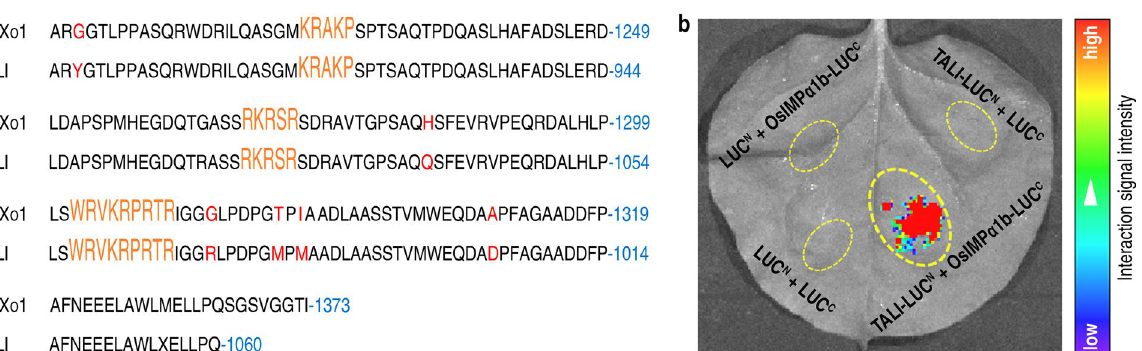
Fig. 4 Alignment of PthXo1 and TALI C-terminal sequences and luciferin (Luc) living fluorescence imaging (LLFI) assay of rice OsIMPα1a and Xoc TALI expressed in tobacco. a Sequence alignment highlighting the conserved consensus nuclear localization signals (NLSs) (taller orange letters) and highlighting differences in residues (in red). The conserved consensus NLSs were identified using the Clustal Omega program (https:// www. ebi. ac. uk/ Tools/ msa/ clust alo/). b LLFI assay representing 12 leaves of 6 tobacco